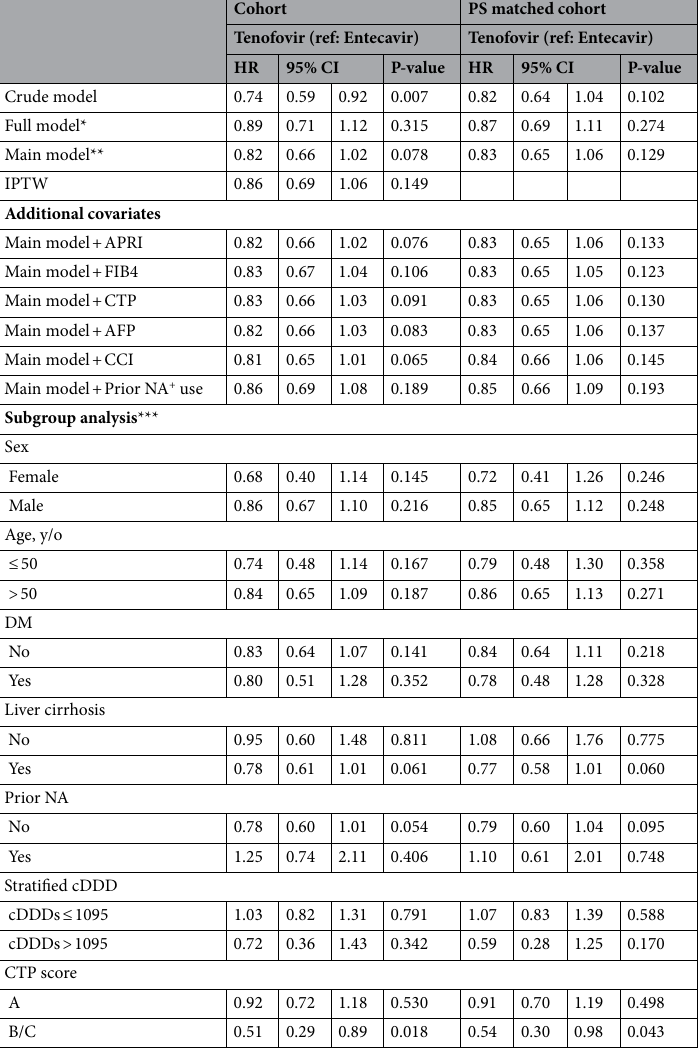
Table 2. HR for HCC. PS propensity score, HR hazard ratio, CT confidence interval, IPTW inverse probability treatment weighting, APRI AST to platelet ratio index, FIB-4 fibrosis index based on 4 factors, CTP Child– Turcotte–Pugh, AFP alpha-fetoprotein, CCI Charlson comorbidity index, NA nucleos(t)ide analogue, DM diabetes mellitus. *Full model is adjusted for age, sex, liver cirrhosis, DM, APRI, FIB4, CCI, CTP, AST, ALT, platelet, AFP, albumin, bilirubin and INR. **Main model is adjusted for age, sex, liver cirrhosis, DM. ***HRs were estimated by fitting the main model. + lamivudine, telbivudine,